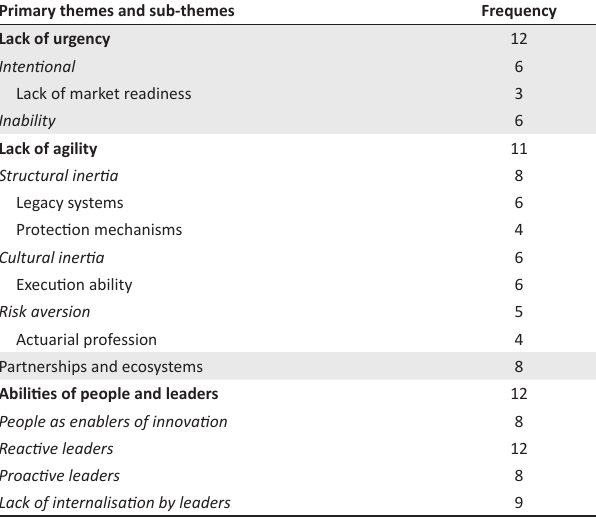
TABLE 2: Summary of